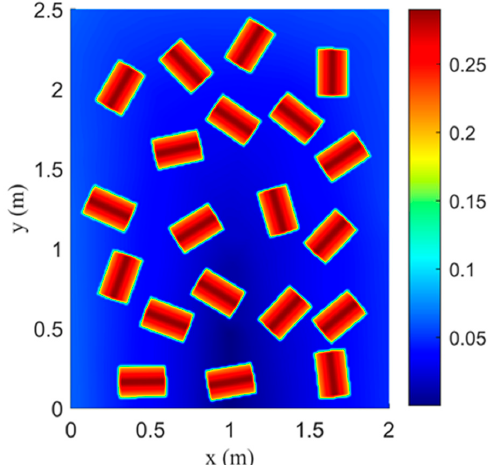
Figure 8. Urban rainfall-runoff experiment: topography of the experimental area.